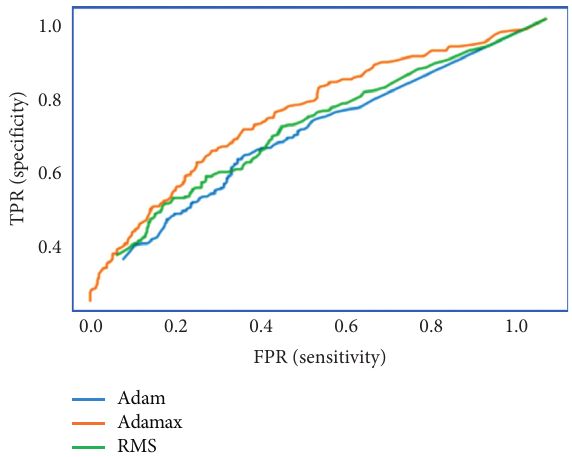
Figure 5: Validation set ROC curve obtained for different opti- mizers on using both OCR text and image captioning